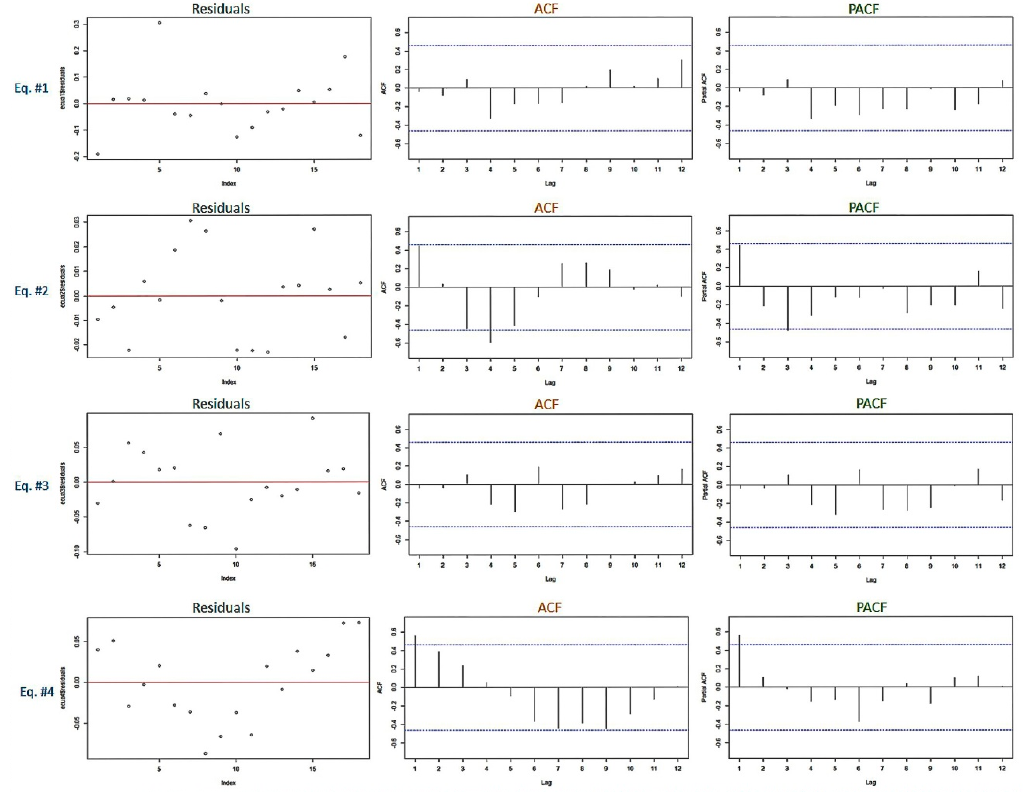
Figure 3. Time series and autocorrelation functions of residuals. Source: own elaboration.